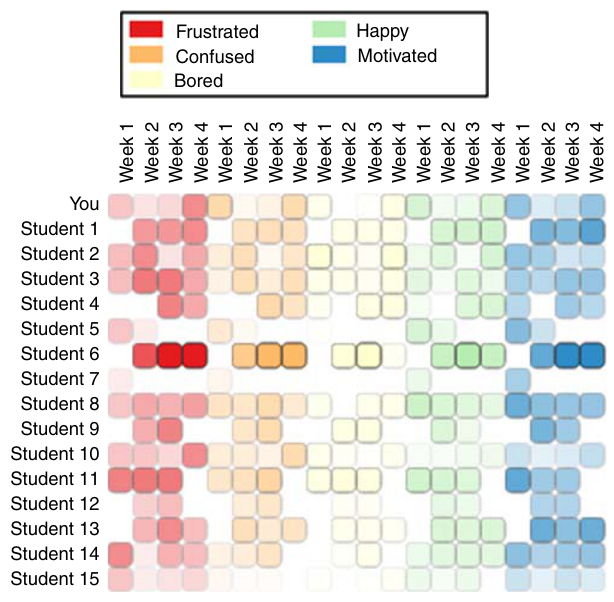
Figure 3. Heatmap visualization of emotion frequency for each learner and each week